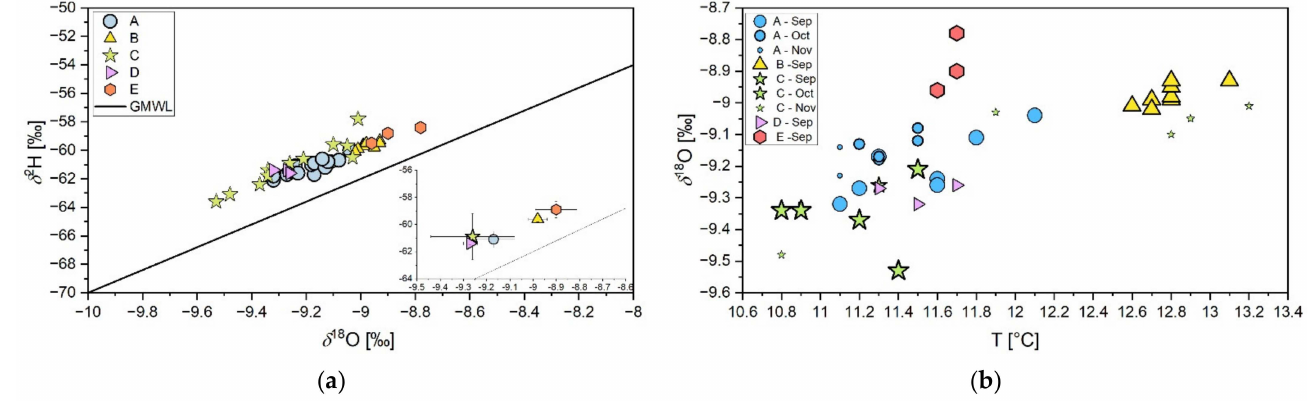
Figure 6. ( a ) Dual isotope plot of wells compared to GMWL. The small picture presents medians of wells regarding the respective wellfield. ( b ) δ 18 O vs. T for wells from different wellfields. Different sized symbols represent different sampling months. A = Kleˇce, B = Hrastje, C = Brest, D = Jarški prod and E =